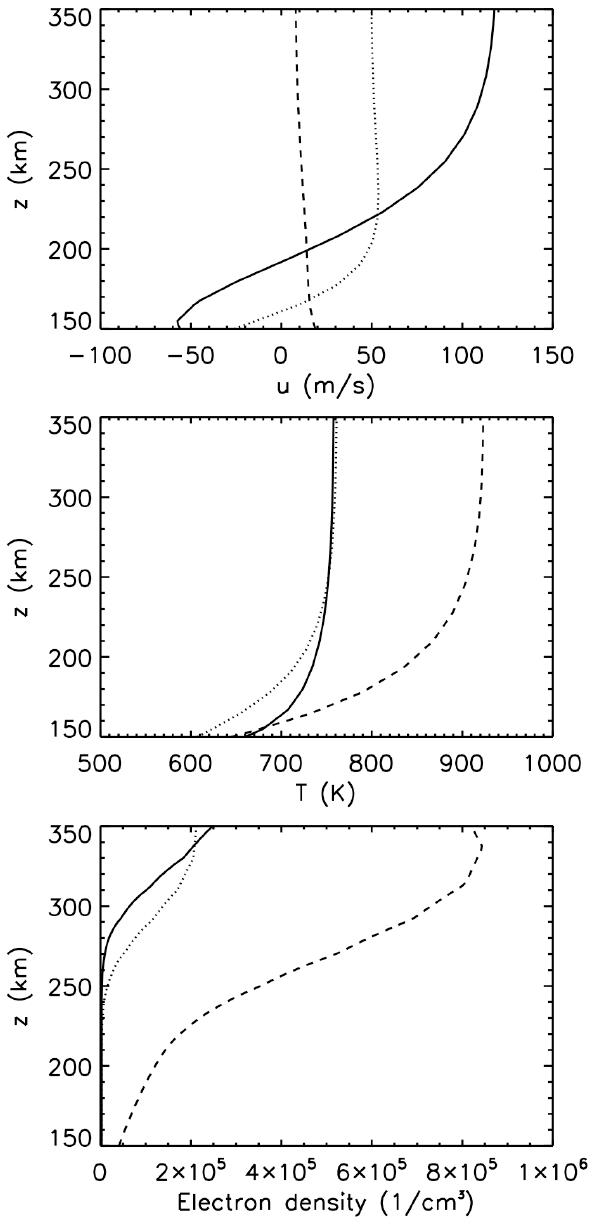
Fig. 5. Zonal wind, temperature, and electron density variations in the thermosphere on 25/26 October 2005 at 50 ◦ W, 12.5 ◦ S over Figure 5 . Brazil at 21:00 (dashed), 00:00 (solid), and 03:00UT (dash-dotted) from a TIME GCM simulation spanning the SpreadFEx campaign period and initialized with the global NCEP reanalysis for this pe-